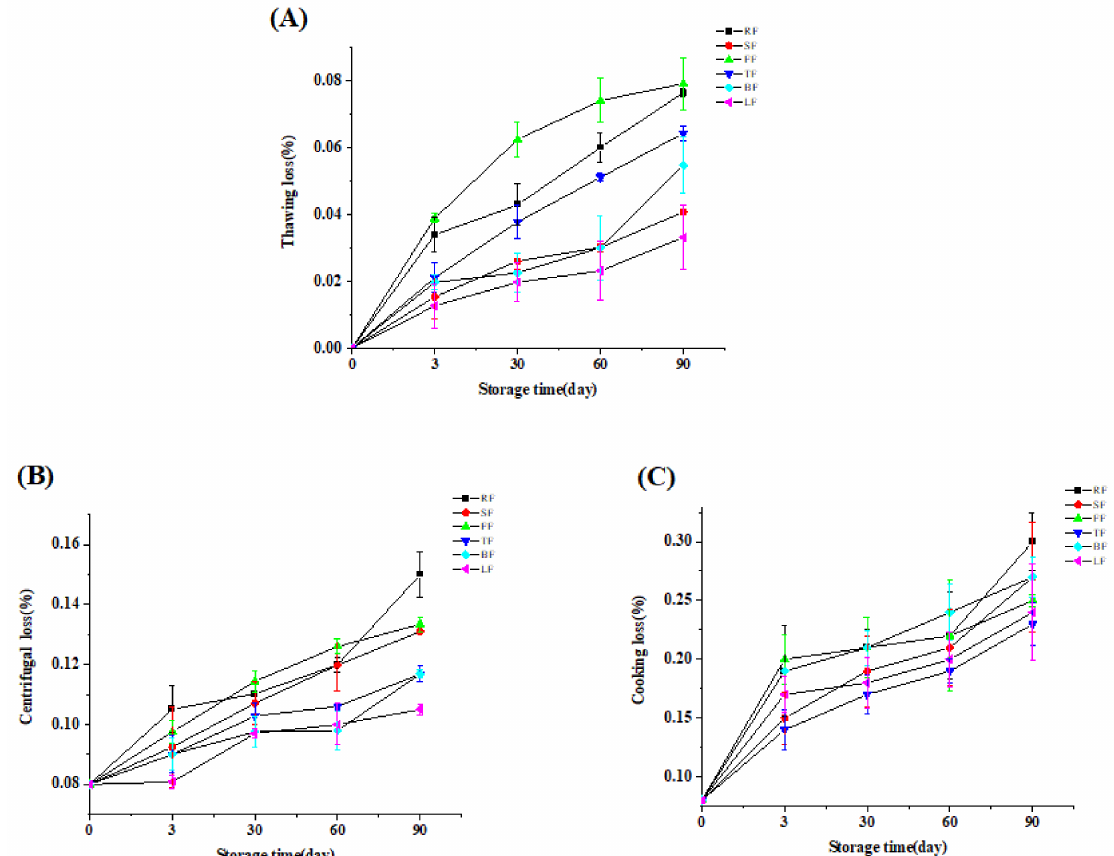
Figure 1. Change in water retention of cuttlefish during storage at − 18 ◦ C by different freezing methods. Thawing loss ( A ). Centrifugal loss ( B ). Cooking loss ( C ). Error bars show standard